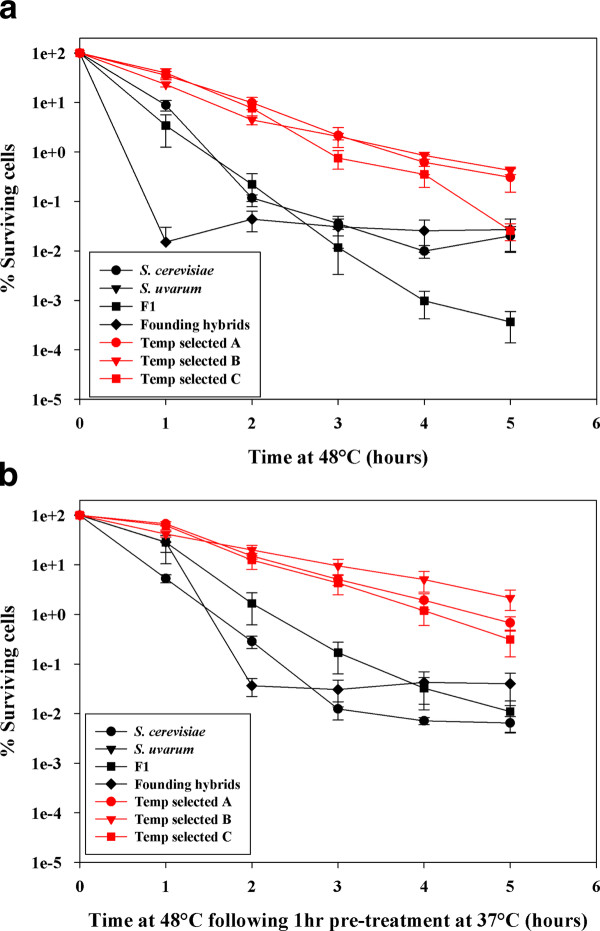
Viability of parental species, F1 and founder interspecifc hybrids, and temperature-selected isolates in liquid culture following exposure to 48°C. (A) Inherent thermal tolerance. A sample of each culture was diluted and plated on 2% YPD every hour for 5 h. No viable S. uvarum cells were detected at the 1 h time-point, thus S. uvarum data are not presented. After 2 h survivorship of the selected isolates was greater than all other isolates (P < 0.05) (B) Induced thermal tolerance. Following overnight culture at 25°C, cells were incubated for 1 h at 37°C prior to exposure to 48°C. Samples of each culture were then diluted and plated every hour for 5 h. No viable S. uvarum cells were detected at the 1 h time-point, thus S. uvarum data and are not presented. After 2 h, survivorship of the selected isolates was greater than the founding hybrids (P < 0.05). Red lines and filled symbols represent the temperature-selected isolates. Experiments were performed in triplicate (Mean ± S.E.).